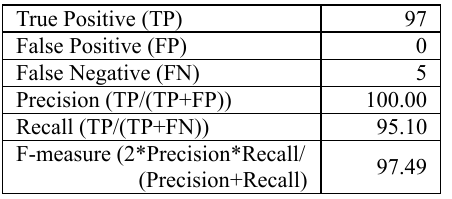
Figure 12 . Image of measuring a roadside tree by the MMS